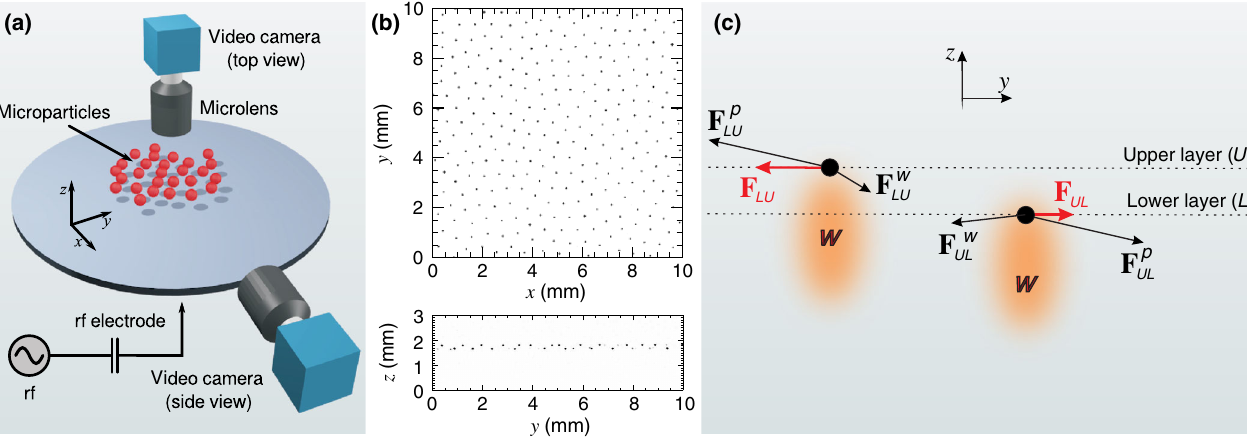
FIG. 3. Scheme of the experimental test and the mechanism of nonreciprocal wake-mediated interactions. (a) Sketch showing the experimental setup. Microparticles levitate above a flat horizontal rf electrode. Two sorts of monodisperse particles form two horizontal monolayers at slightly different levitation heights. The layers are observed with the top-view and side-view video cameras, providing complete information about the position of individual particles. (b) Top and side views of a binary mixture forming the two layers. The respective images are obtained by illuminating the particles with thin horizontal and vertical laser sheets. (c) The total force exerted on the upper-layer ( U ) particle from the lower-layer ( L ) particle is the sum of the repulsive force F p LU of direct interparticle interaction and the attractive force F w LU from the wake of the lower particle (and similar for the total force on the lower particle). While the direct forces are reciprocal, F p LU ¼ − F p UL , the wake forces are not, F w LU ≠ − F w UL ; since the forces decrease with the distance, we have j F w LU j < j F w UL j and therefore j F LU j > j F UL j . Thus, the total horizontal forces (relevant for the analysis) can be written as F LU ¼ ð 1 þ Δ Þ F 0 for the upper layer and F UL ¼ − ð 1 − Δ Þ F 0 for the lower